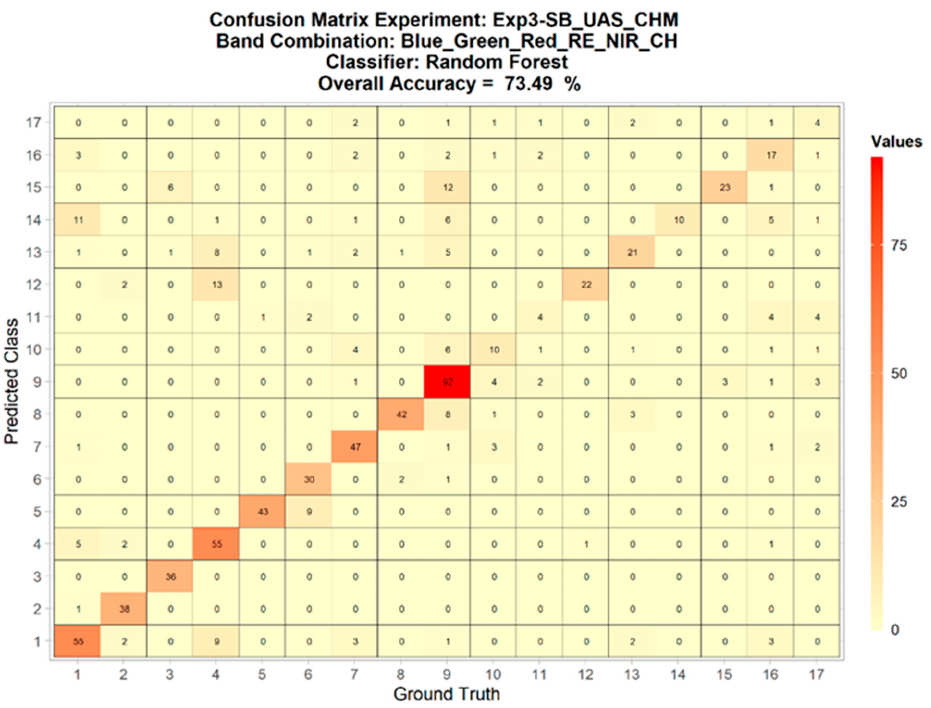
Figure A18. Confusion matrix for the best results obtained in Exp3-SB_ UAS_CHM, using the Random Forest classifier (the Blue_Green_Red_RE_NIR_CH band combination).